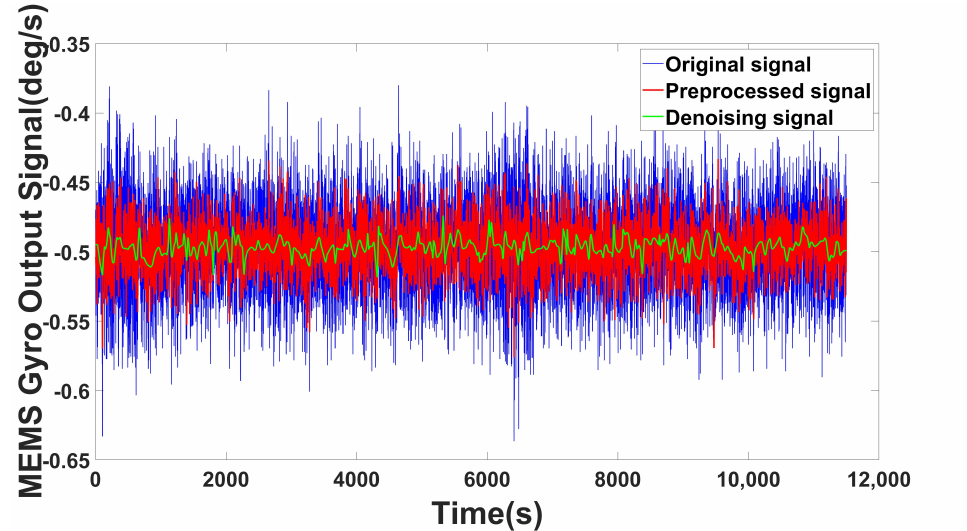
Figure 9. Denoising result of ICELMD (MPU6050 with abnormal signal).